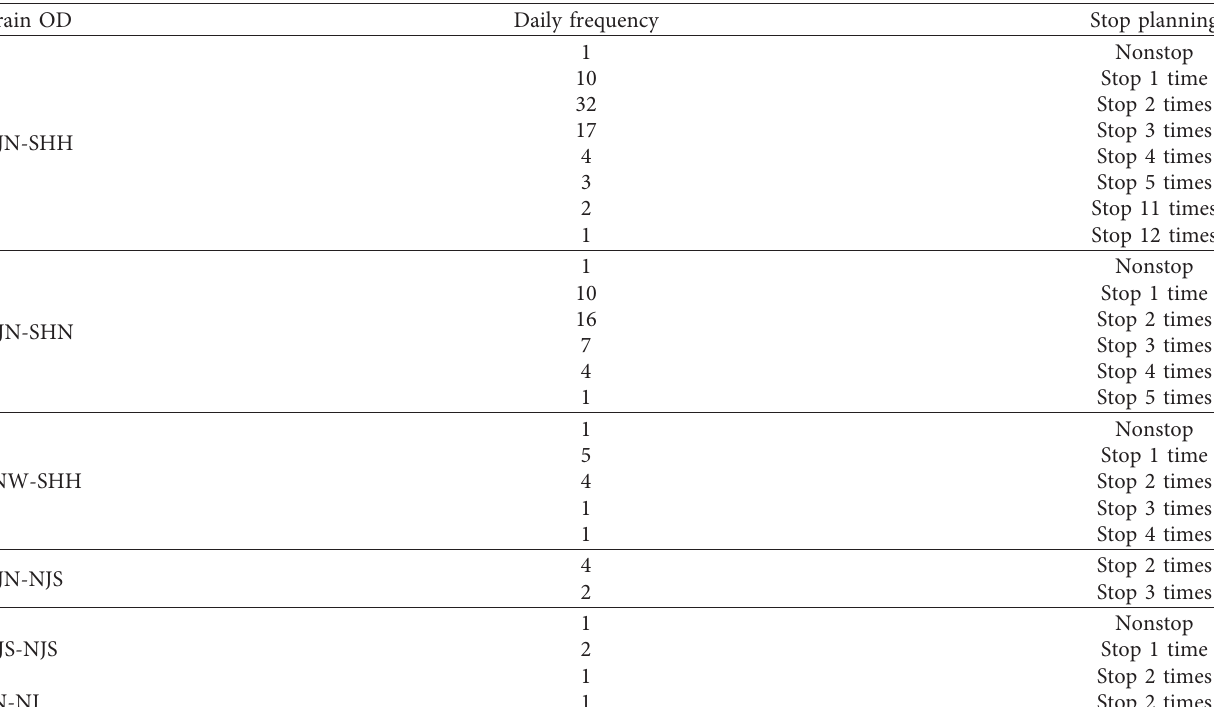
Figure 5: The convergence of the BD & VC and BD. Table 5: The PTSP for the Beijing-Shanghai HSR